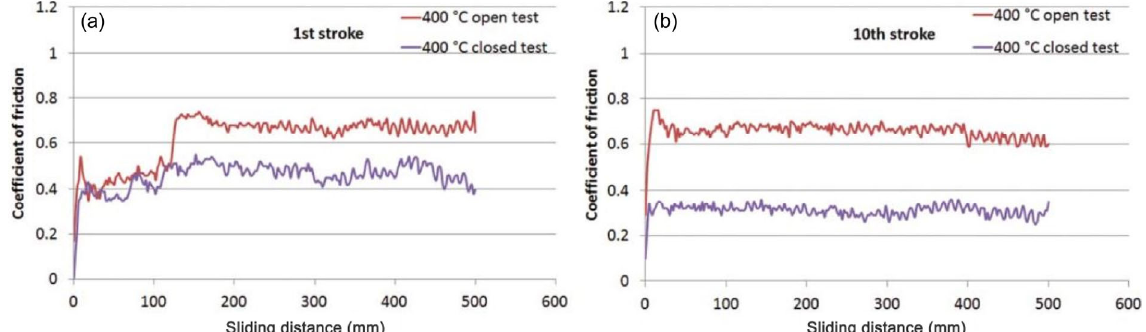
Fig. 22 Coef fi cient of friction as a function of sliding distance at 400 ° C for (a) the fi rst stroke and (b) the tenth stroke. Reproduced with permission from Ref. [535]. © Taylor & Francis,